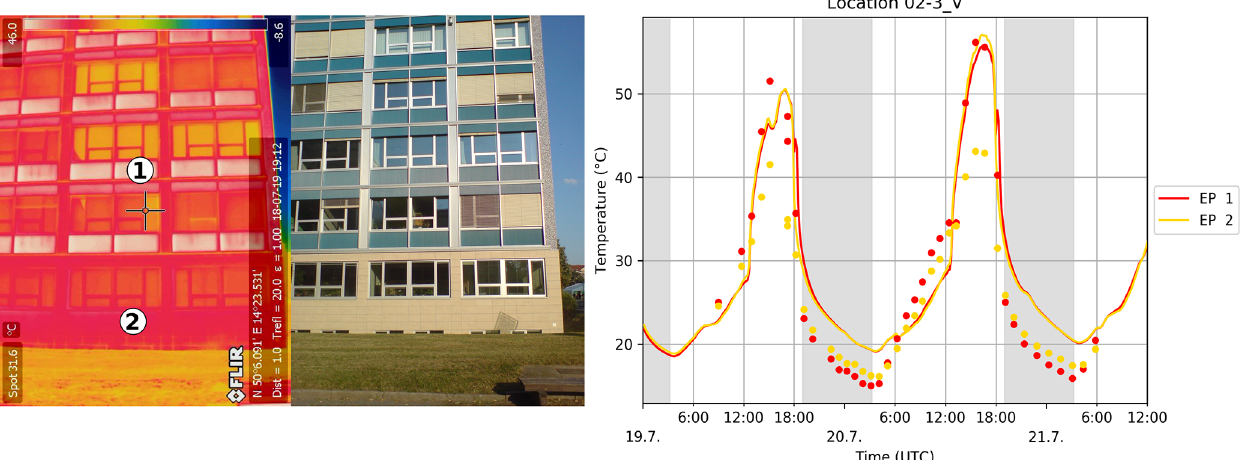
Figure 15. Observation location 2-3_V: the left panel shows IR and RGB photos of the building with placement of the evaluation points, and the right panel shows a graph of observed (dots) and modelled (lines) surface temperature for particular evaluation points (EP) for the summer e2 episode. The grey areas denote